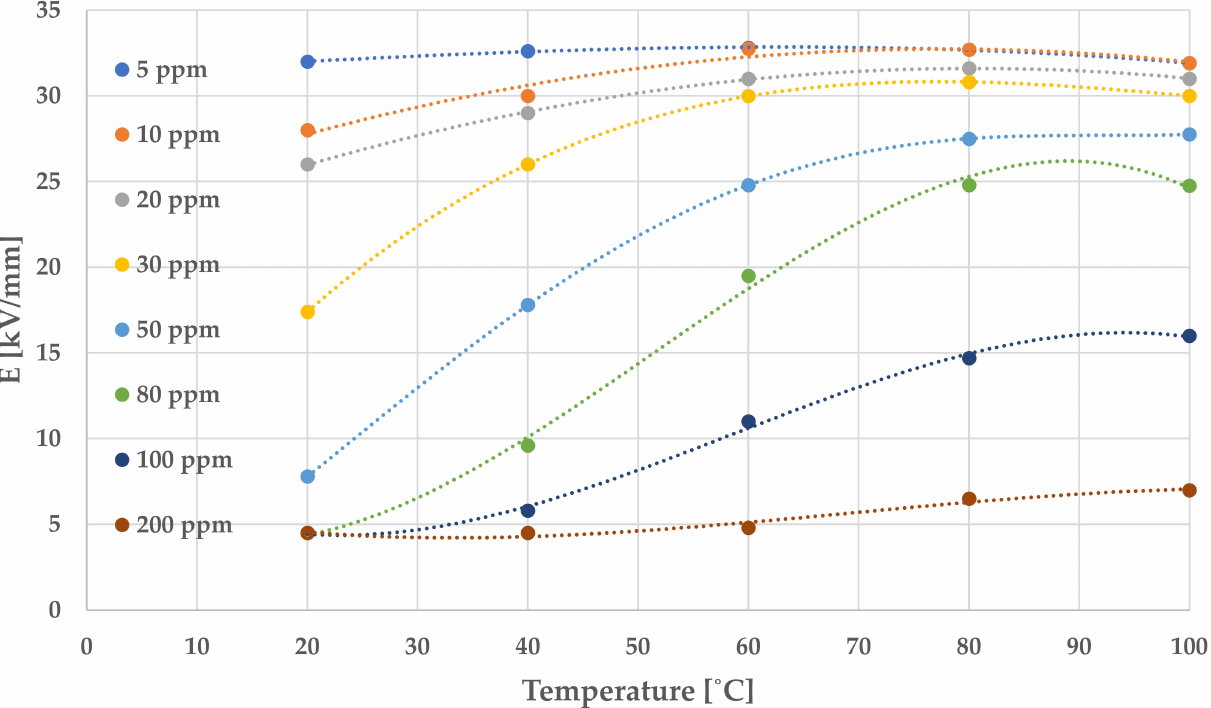
Figure 2. Relationships between the electric strength of mineral oil and temperature at different levels of moisture content in oil, the curves were elaborated on the basis of data presented in